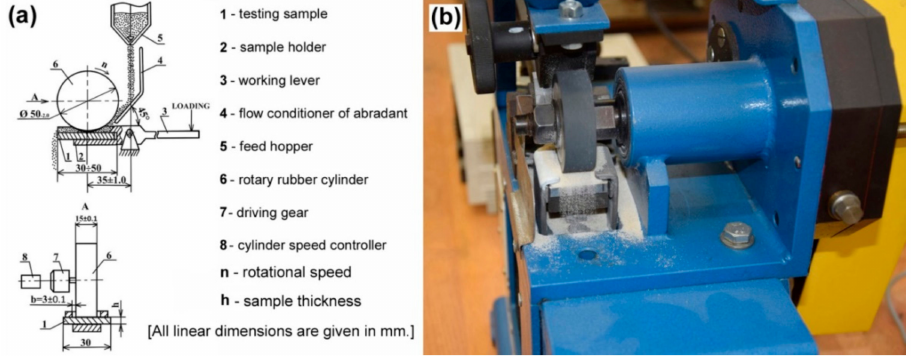
Figure 1. Testing apparatus for three-body abrasive wear test according to “ ГО C Т